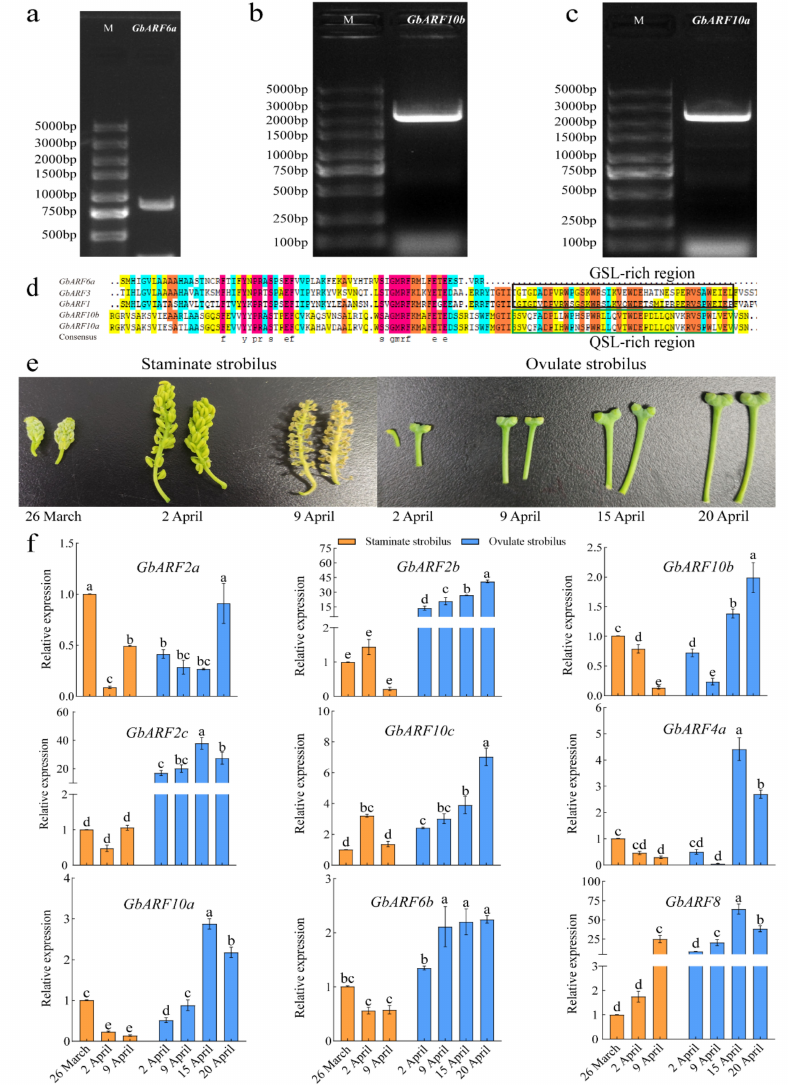
Figure 8. PCR amplification of GbARF6a ( a ), GbARF10b ( b ), GbARF10 a ( c ) and identification of ARF domain ( d ). ( e ) Developmental stages of staminate strobilus and ovulate strobilus. ( f ) Relative expression of 9 GbARFs during male and female flower development in Ginkgo. Orange and blue vertical bars represent staminate strobilus and ovulate strobilus, respectively, expression levels were indicated as means ± standard deviation (SD), different letters denote a significant difference of 0.05 in Duncan’s multiple range